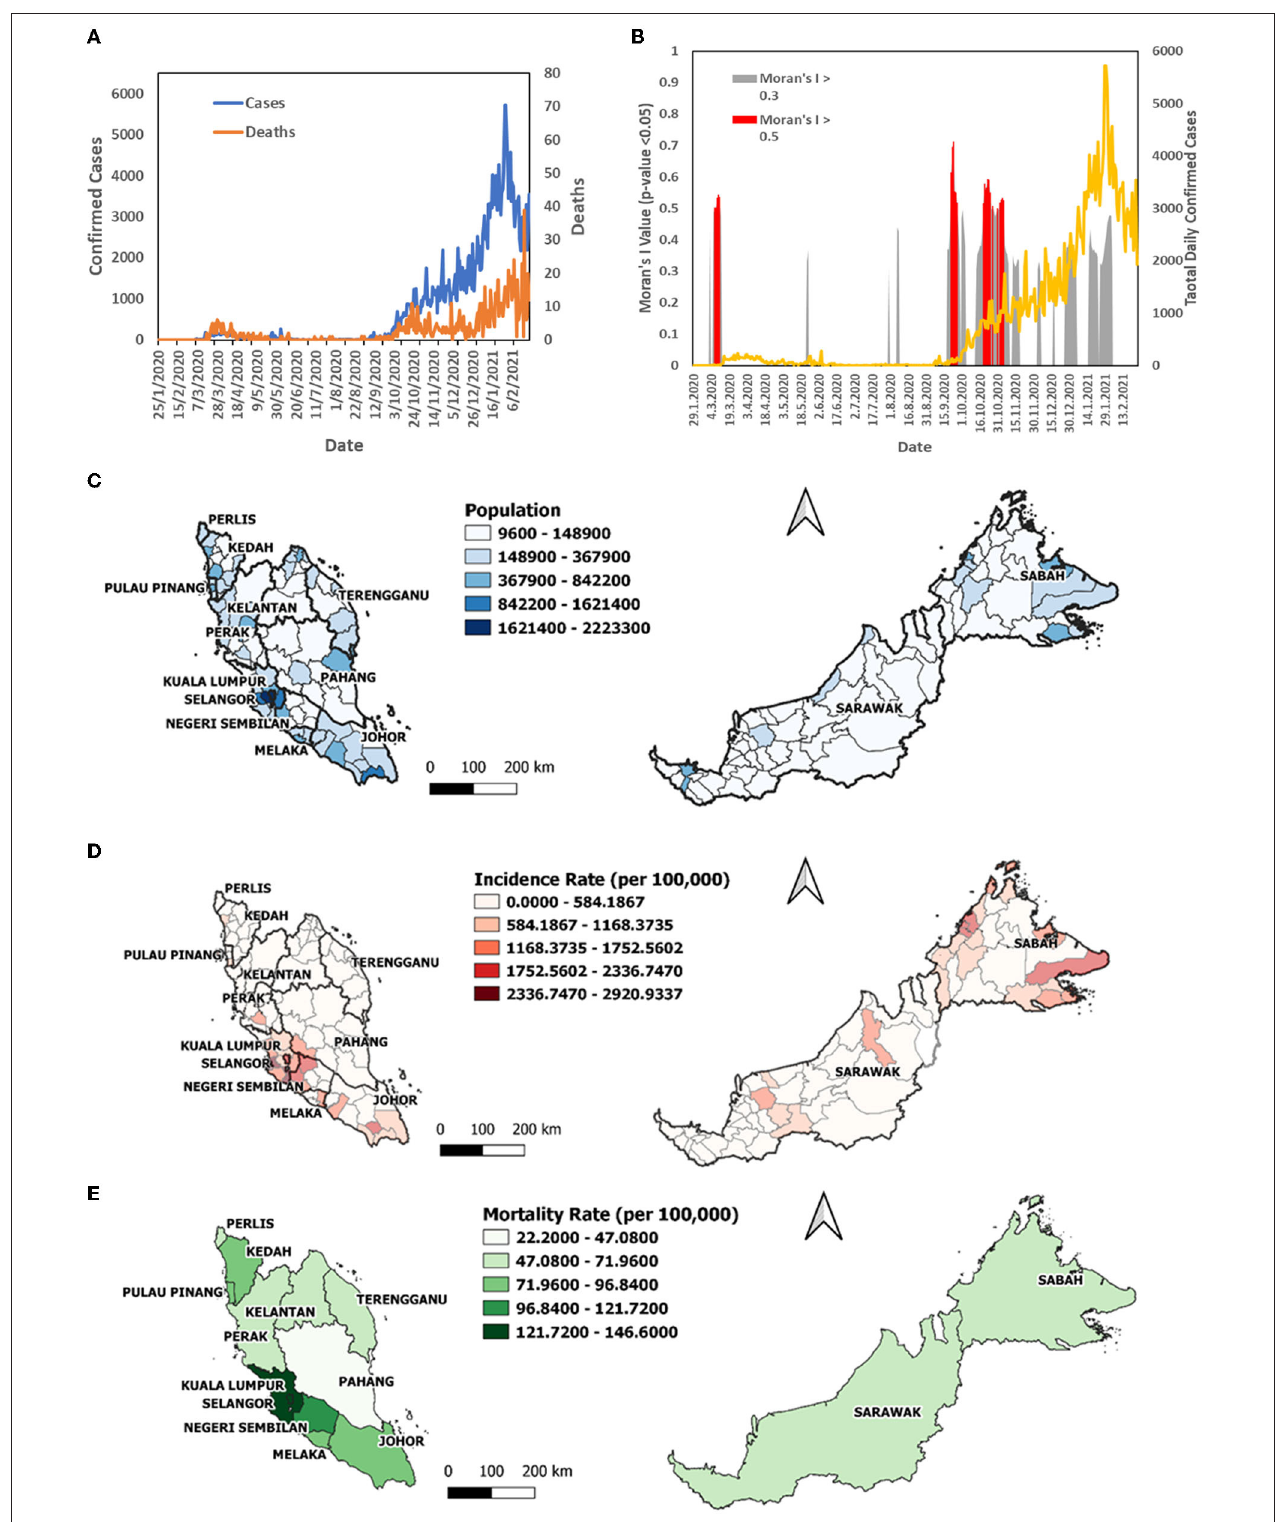
FIGURE 1 | The COVID-19 case profile in Malaysia from January 25, 2020 to February 24, 2021; (A) total daily confirmed cases, daily mortality; (B) Moran’s I > 0.5 over the same period; (C) map of population by district; (D) map of incidence rate per 1,00,000 population by district; (E) map of mortality rate per 1,00,000 population by